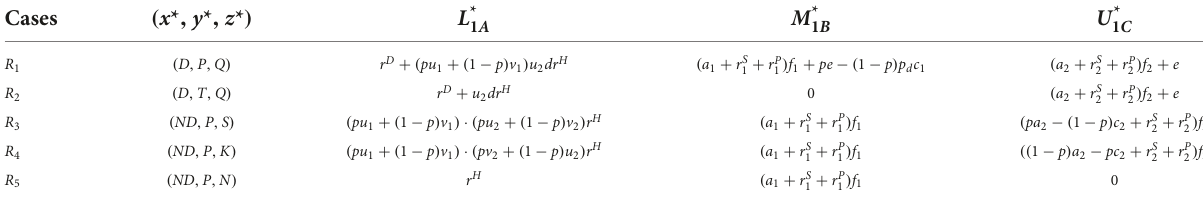
TABLE 2 Equilibrium values of the rumor clarification